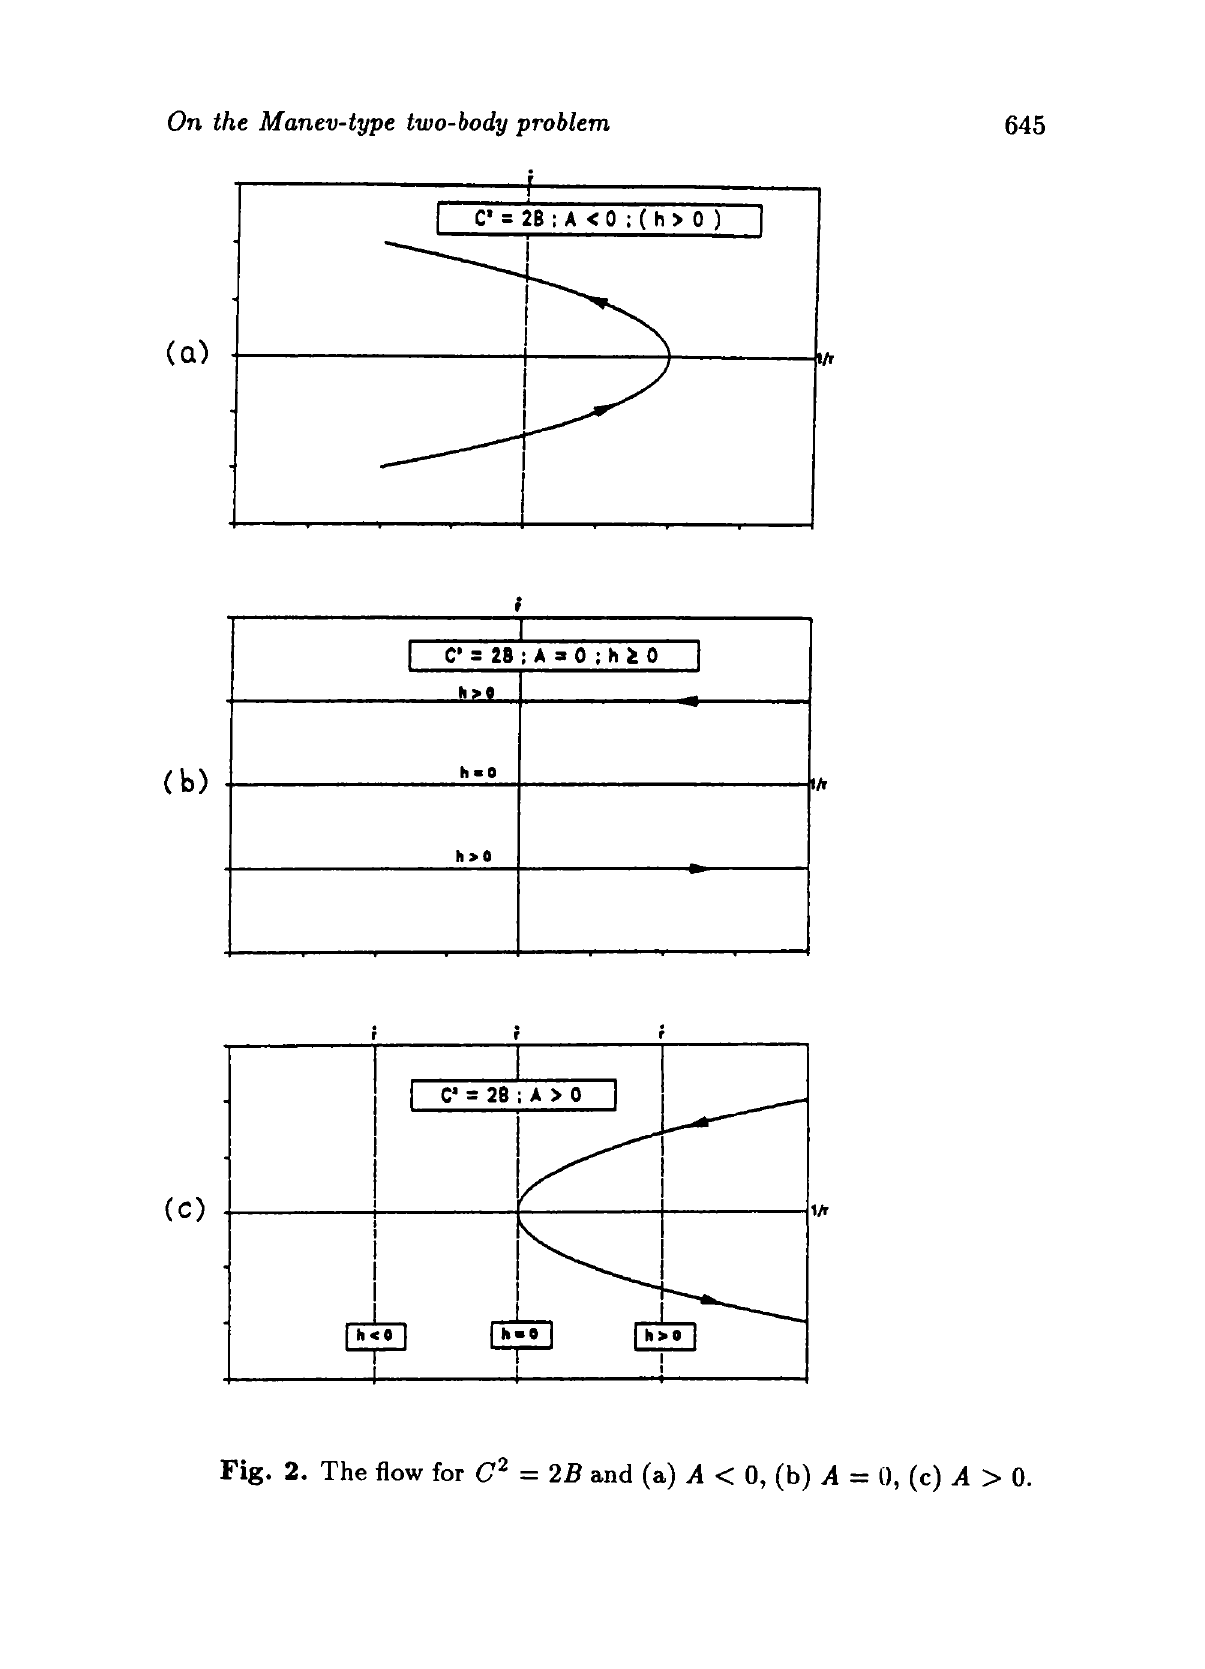
Fig. 2. The flow for C 2 = 2 B and (a) A < 0, (b) A = 0, (c) A >